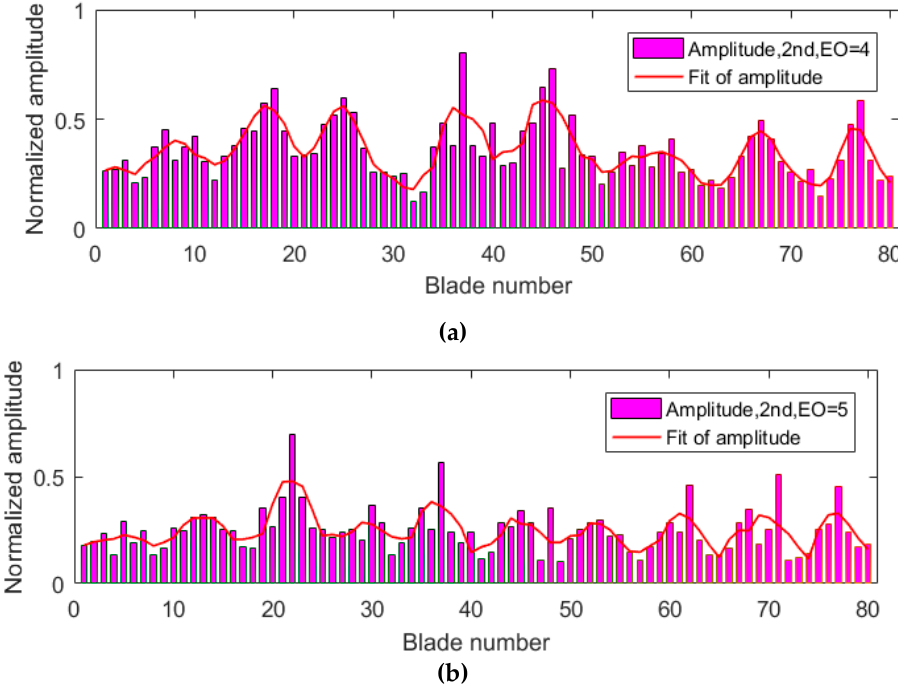
Figure 11. Normalized amplitudes of all blades in the second test: ( a ) EO = 4 and ( b ) EO =